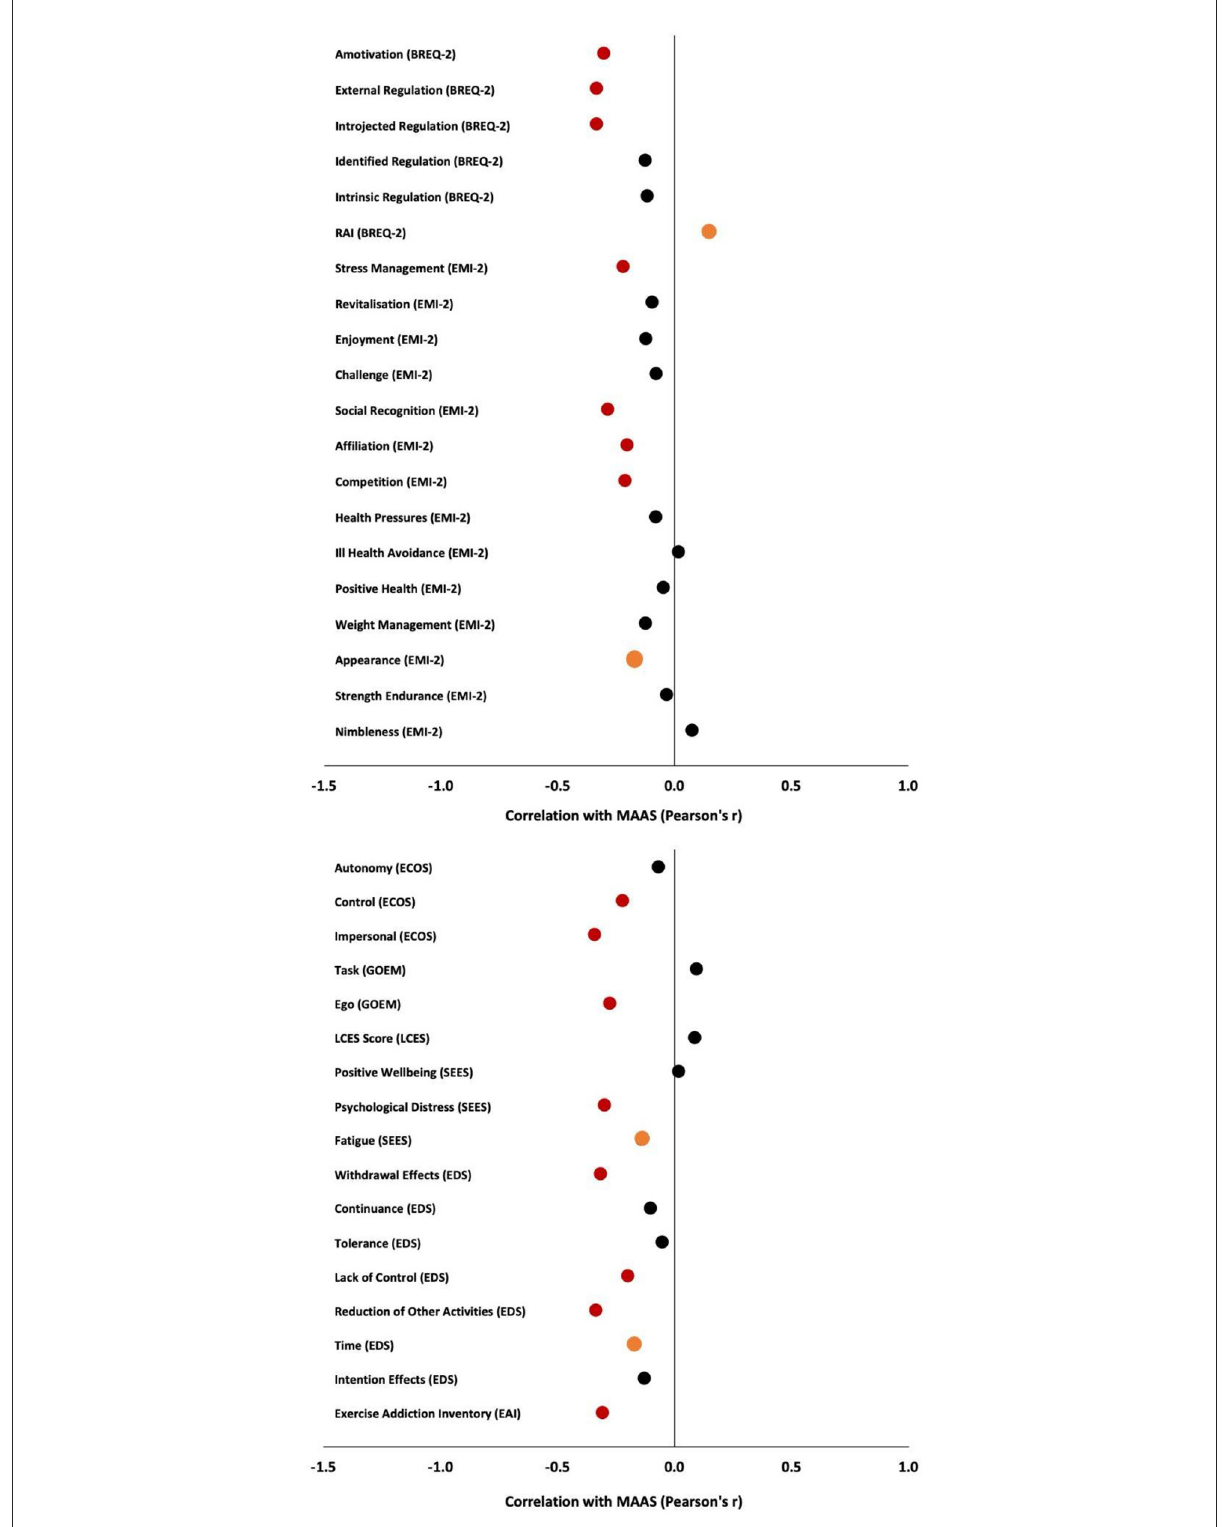
FIGURE1 Correlations between Mindful Attention Awareness Scale (MAAS) and study measures of interest. Red circles indicate significance, orange circles indicate trends toward significance, and black circles indicate